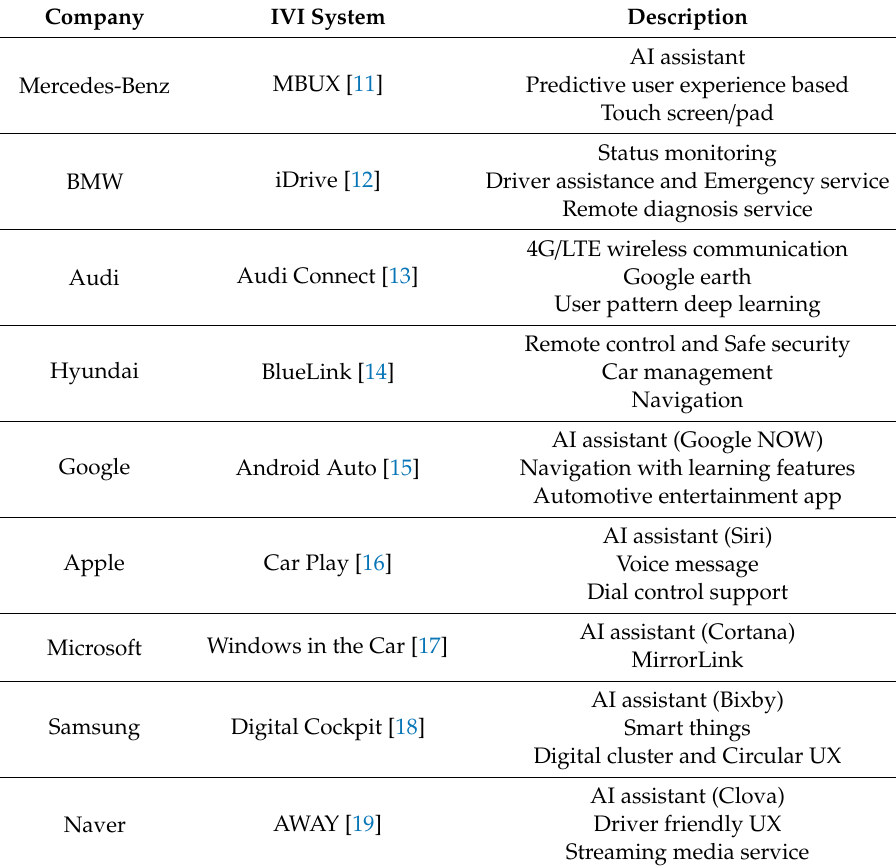
Table 1. IVI systems and services by